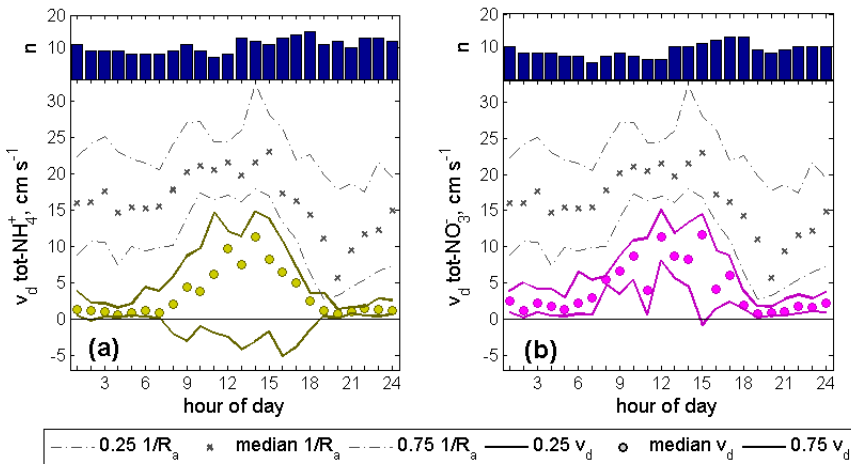
Fig. 5. Median diel variation of dry deposition velocities ( v d ) for tot-NH + in cms − 1 , September 2007 at the Weidenbrunnen site. Only data under favourable conditions (no rain, RH < 95%, high visibility) are considered. Values of 1/ R a (including inter-quartile ranges) are shown as a proxy for the maximum possible v d . The number of data points used for every hour to calculate medians and inter-quartile ranges (0.25 and 0.75) are given on top of each graph (blue bars).